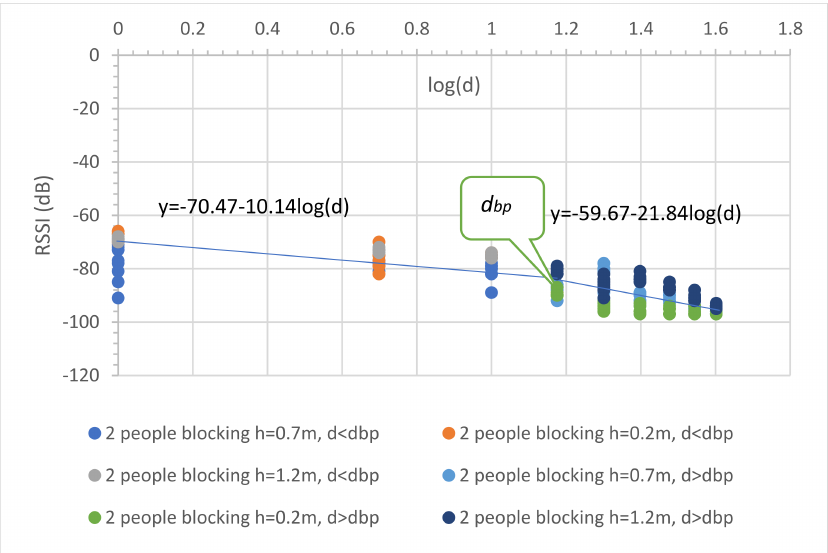
Figure 8. Uncertainty in observed RSSI and distance with two people (farmers) blocking, for all antenna